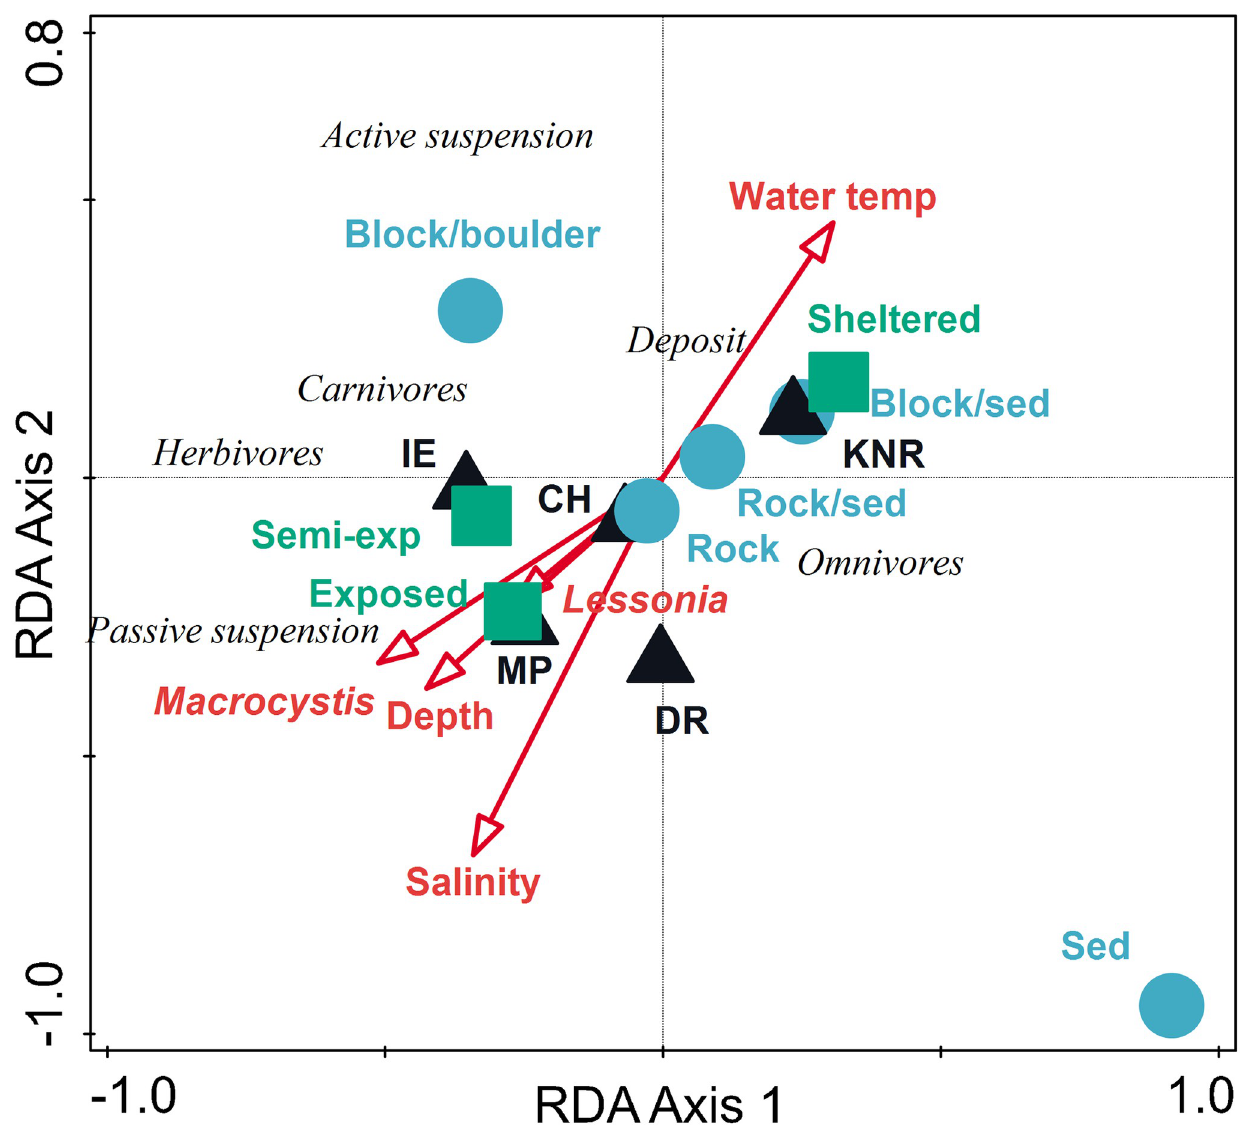
Fig 6. Triplot of results of redundancy analysis on benthic feeding guild abundance by region with biotic and abiotic variables (wave exposure, depth, salinity, temperature, densities of Macrocystis and Lessonia kelp). Data were centered and ln(x+1) transformed benthic taxa abundance by transect. Biotic and abiotic variables were standardized prior to